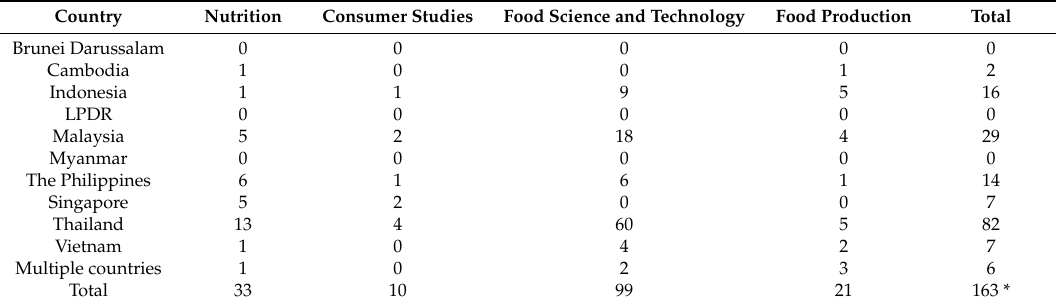
Table 1. Summary of literature search results on whole grains in Southeast